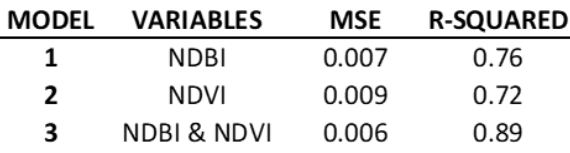
Table 2. Performance of the random forest regression models considering NDBI and/or NDVI.